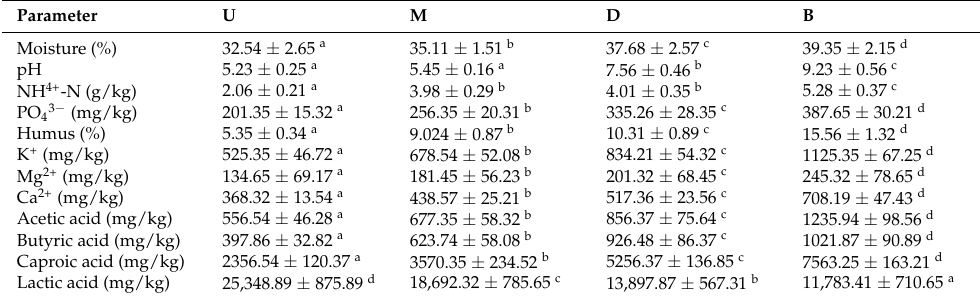
Table 3. The physicochemical properties of pit mud samples from different spatial positions of the